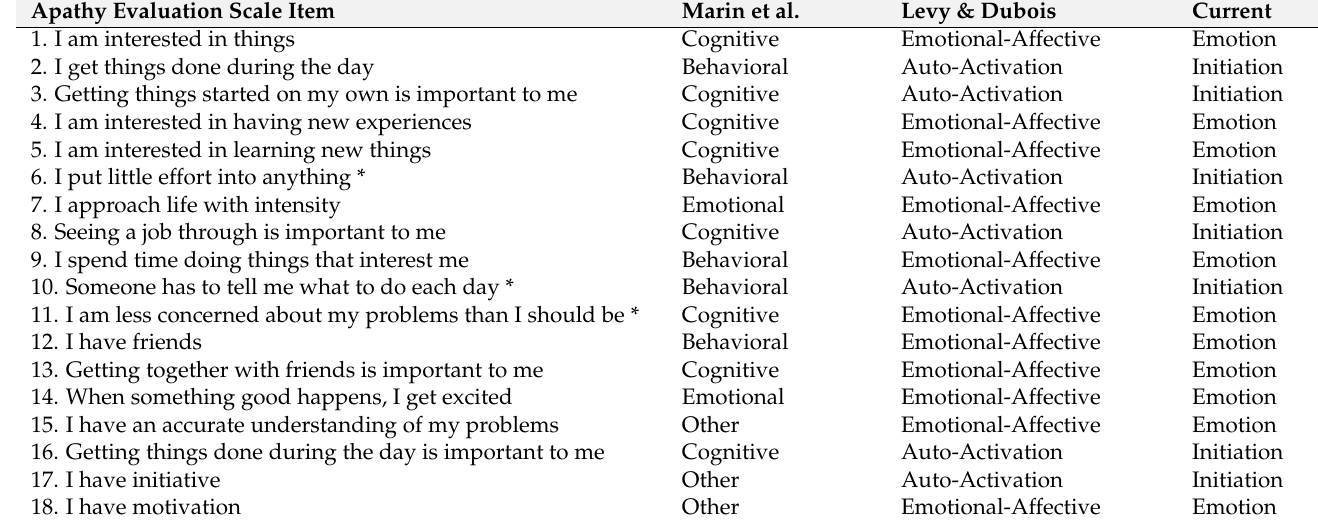
Table A1. Comparison of apathy evaluation scale items according to the original subscale [11], Levy and Dubois apathy subtypes [10], and the current apathy dimensions, based on Radakovich and Abrahams [37]. Apathy Evaluation Scale